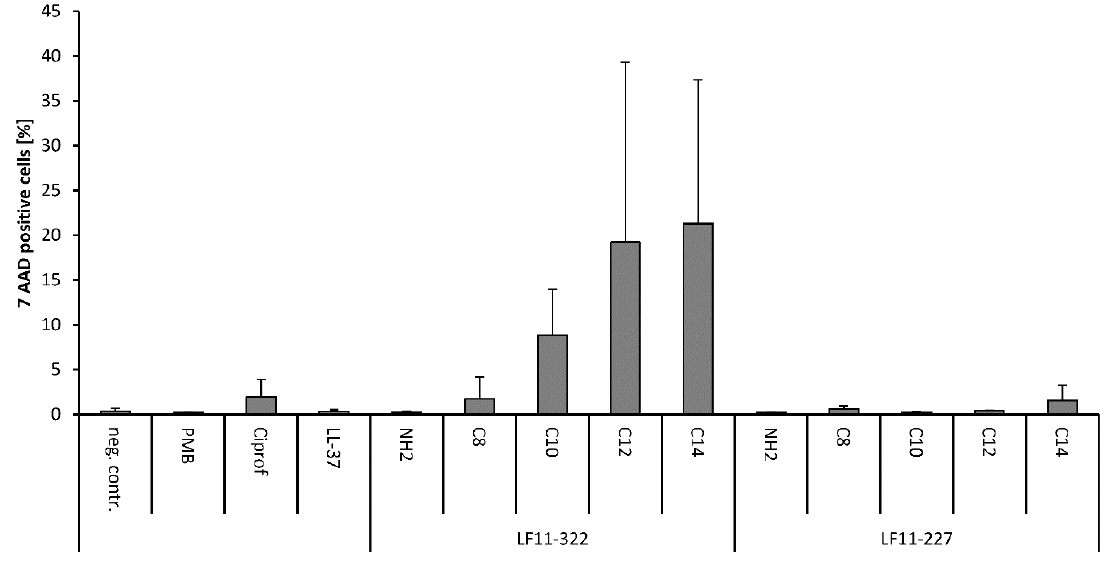
Figure 8. The cytotoxic property of AMPs on human leukocytes was measured by flow cytometry. Whole blood was spiked and incubated with 128 µg/mL AMP, PMB and conventional antibiotics. The apoptotic and dead cells were labelled with the 7-AAD dye and quantified with the flow cytometer ( n = 3).